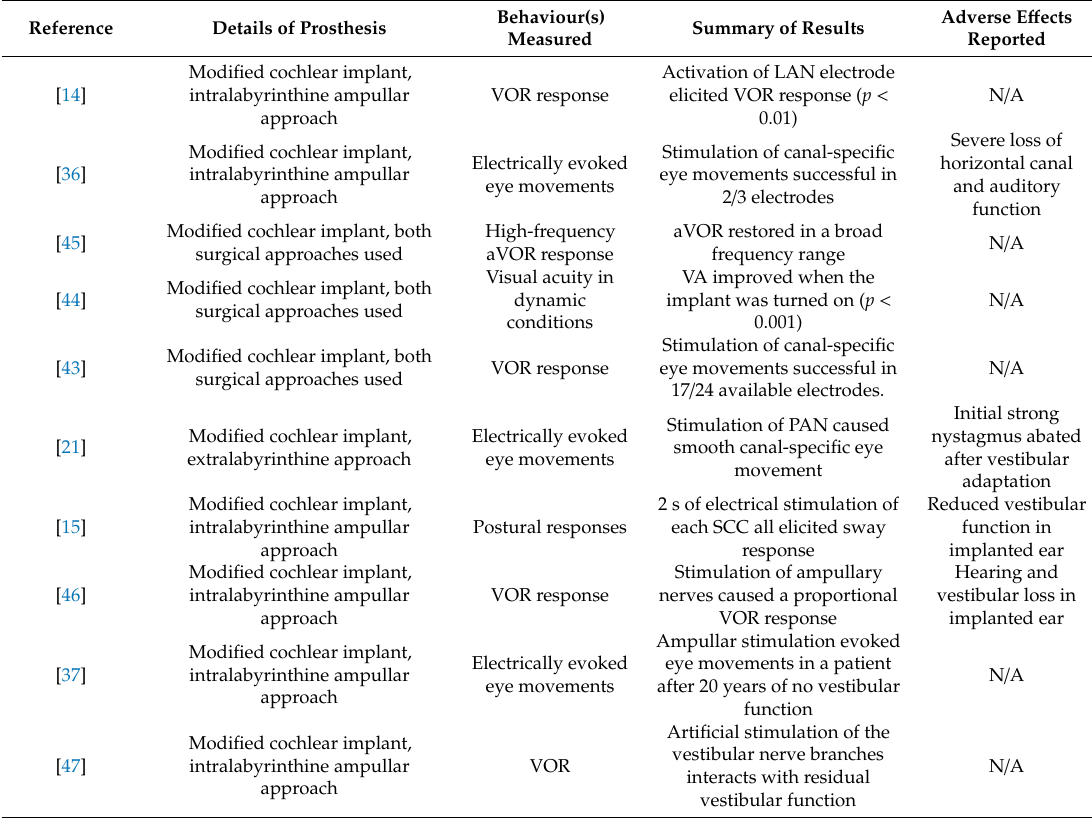
Table 3. The characteristics of studies investigating artificial electrical stimulation of the human vestibular system via implanted electrodes. A concise summary of prosthetic design, behaviour(s) measured, key results reported and adverse e ff ects